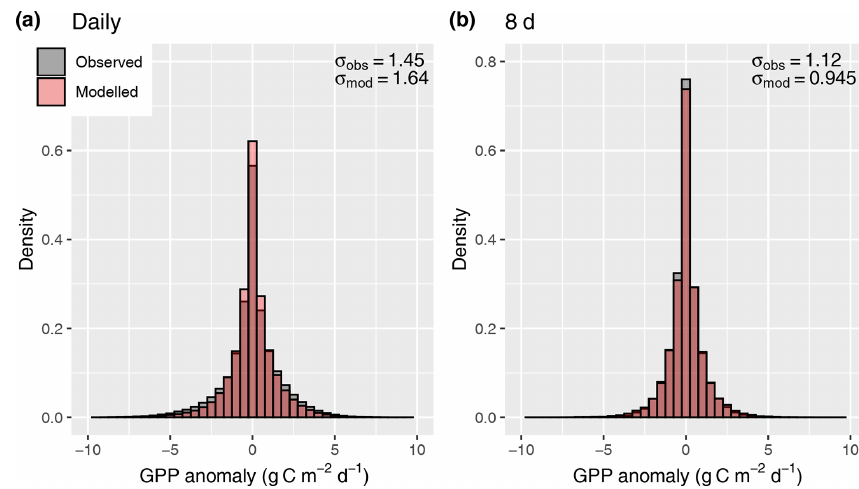
Figure 12. Distribution of anomalies from the mean seasonal cycle, evaluated for daily values (a) and 8d means (b)